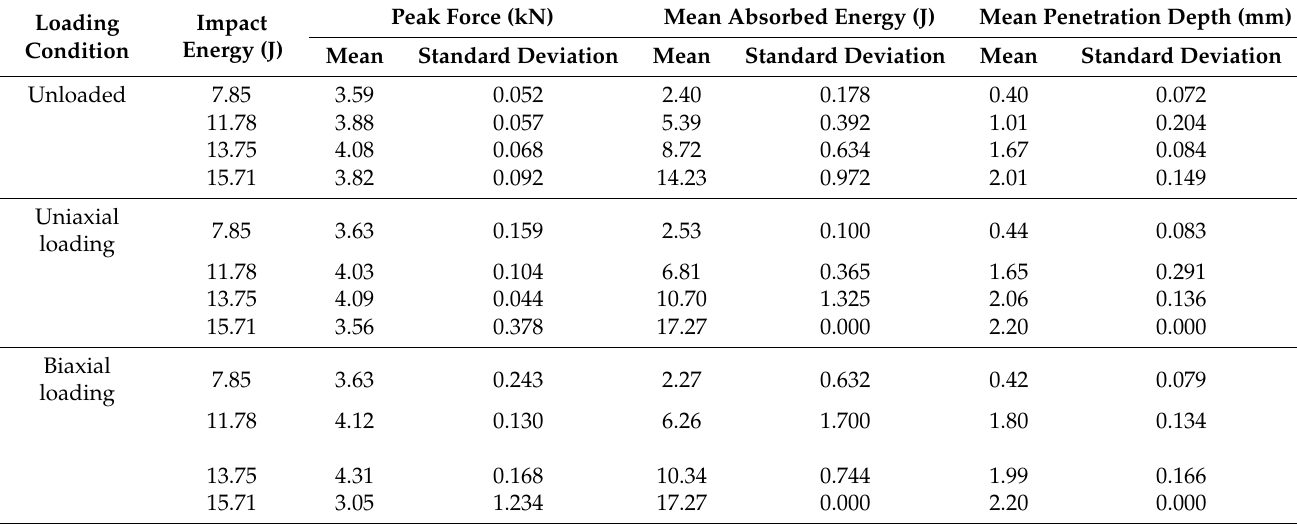
Table A1. Results from the drop tower